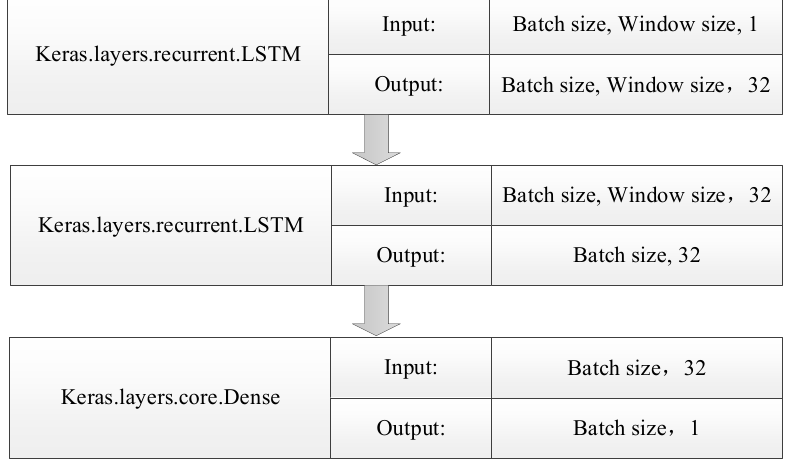
Figure 4. Data flow on the network